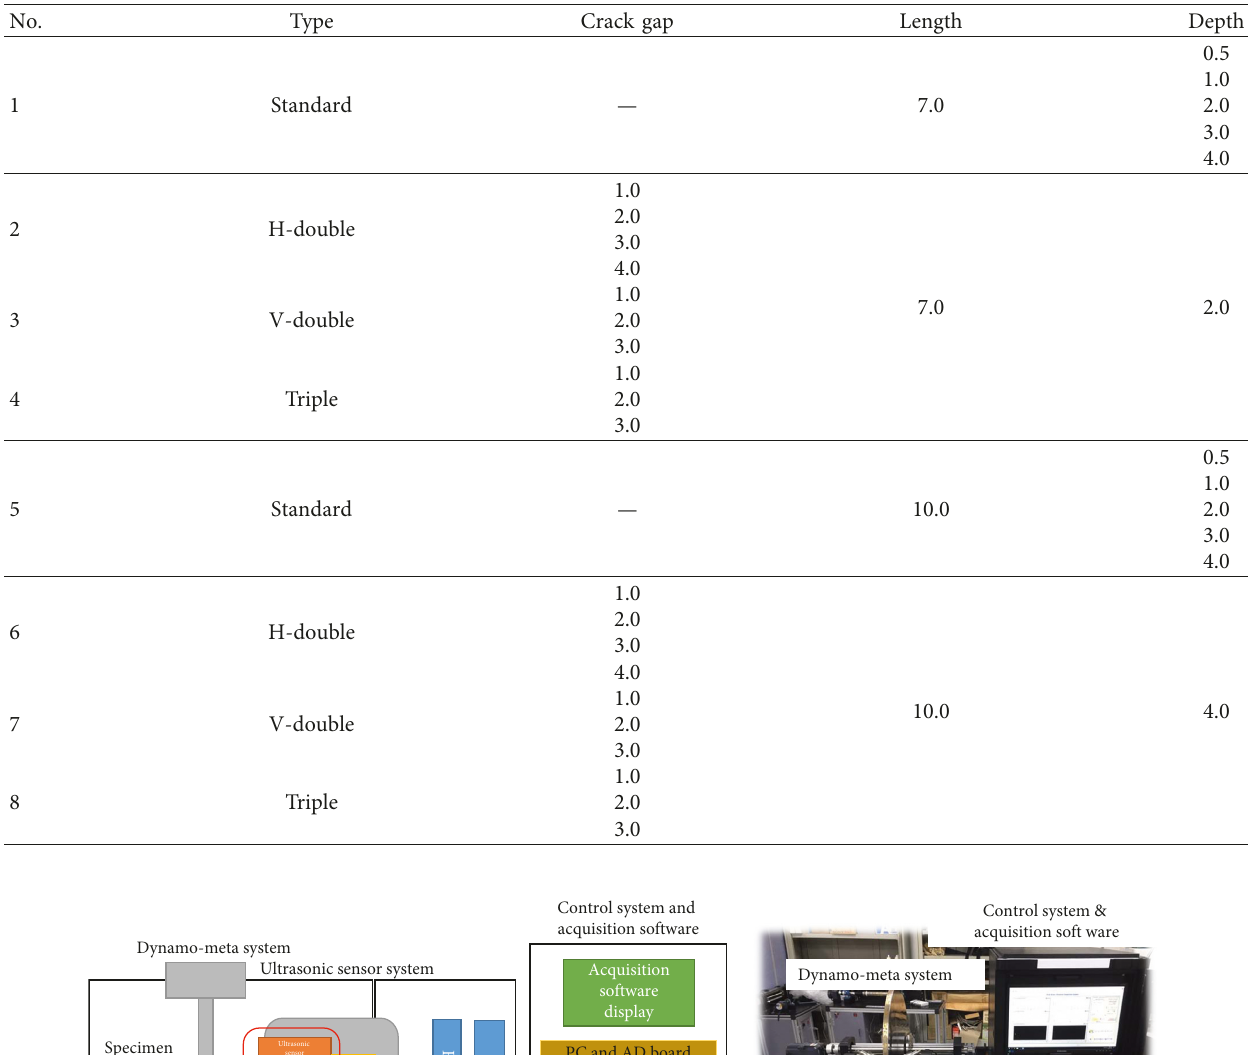
Table 1: Specification of cracks in the brake disc specimen (mm).